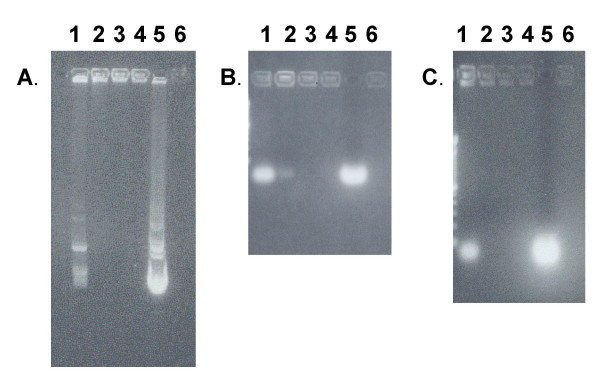
Gel retardation of Genzyme lipid 67 (GL67)-complexed plasmid DNA, siRNA and asODN . Plasmid DNA (A), siRNA (B) or asODN (C) were complexed to GL67 at different lipid:nucleic acid molar ratios and complexes were separated on agarose gels. (Lane 1 = 0.25:1, 2 = 0.5:1, 3 = 0.75:1, 4 = 1:1 lipid: nucleic acid molar ratios, 5 = no lipid control, 6 = empty well).